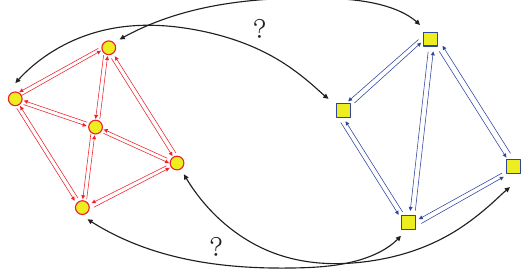
Figure 4. An example of GM